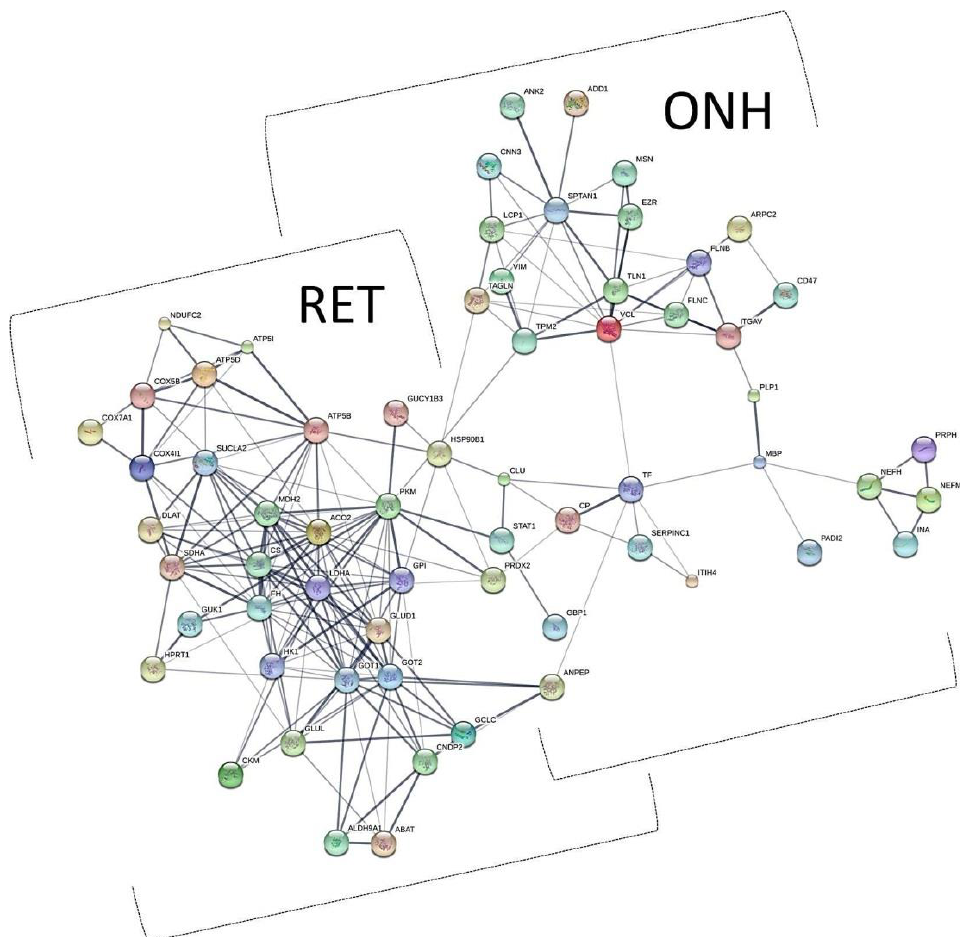
Figure 9. Molecular function determination of ONH/RET-specific proteins by gene ontology (GO) analysis. Most tissue-specific proteins display protein-binding features.